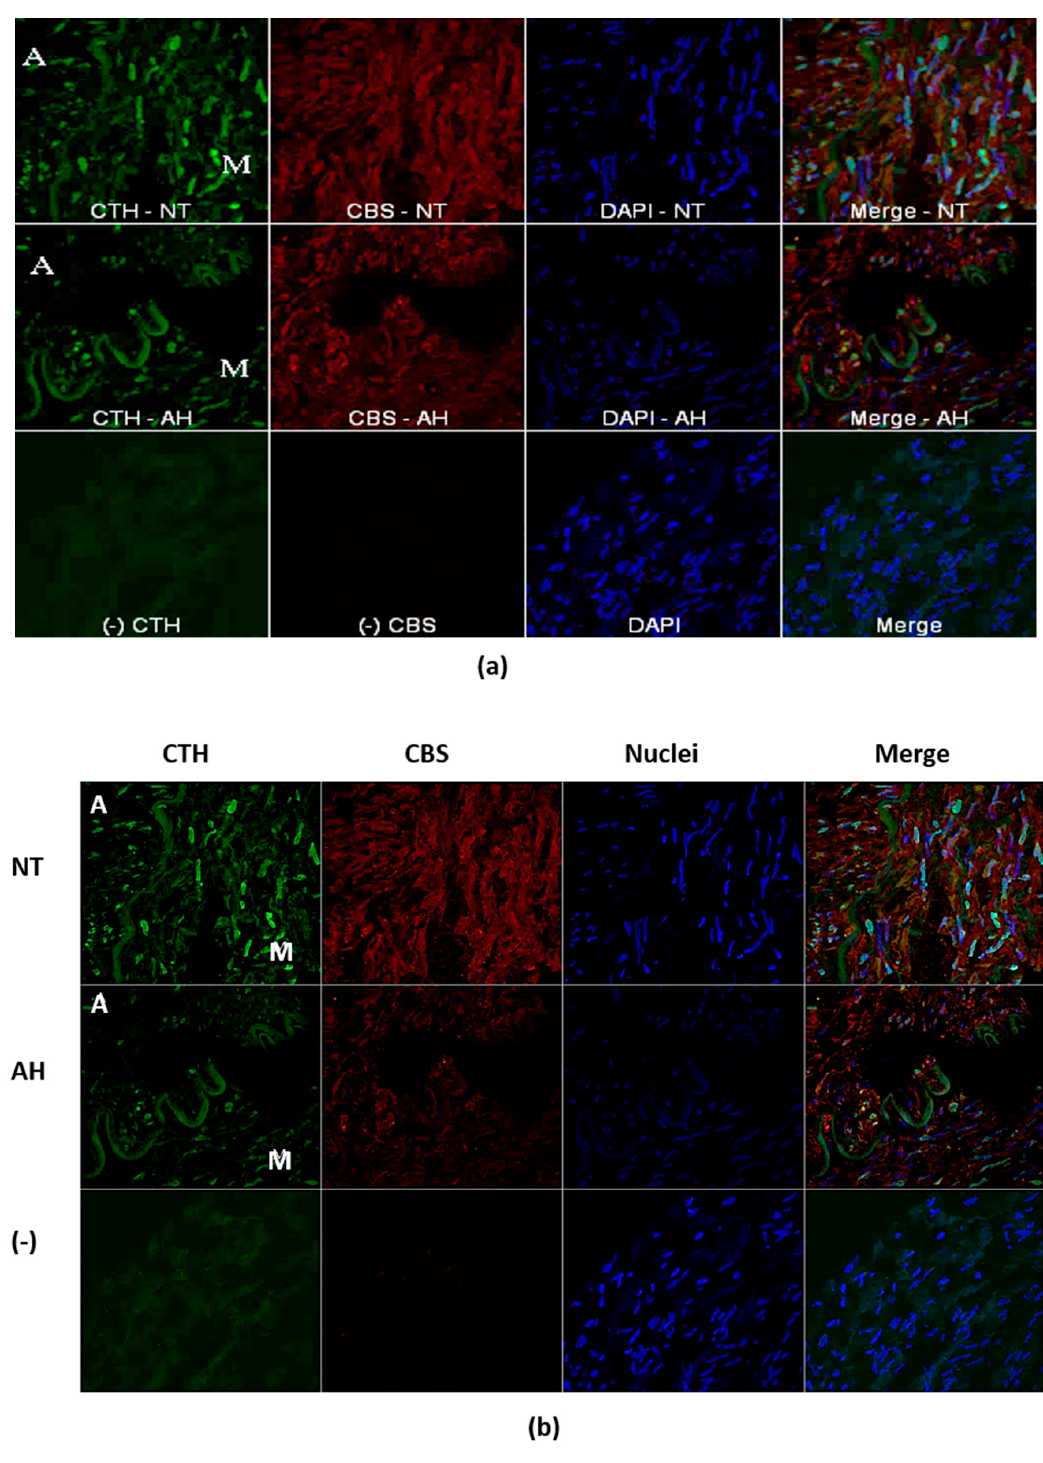
Figure 2. Representative immunofluorescence images in samples of normotensive patients (NT) and patients with arterial hypertension (AH) in arterial wall ( a ). Immunofluorescence localization of cystathionine beta-synthase (CBS-red), cystathionine gamma-synthase (CTH-green) and nuclei (blue) ( b ). M- media, A – adventitia, DAPI - 4 ′ ,6-diamidino-2-phenylindole, a fluorescent stain. ( − ) - represents omitted primary antibodies.